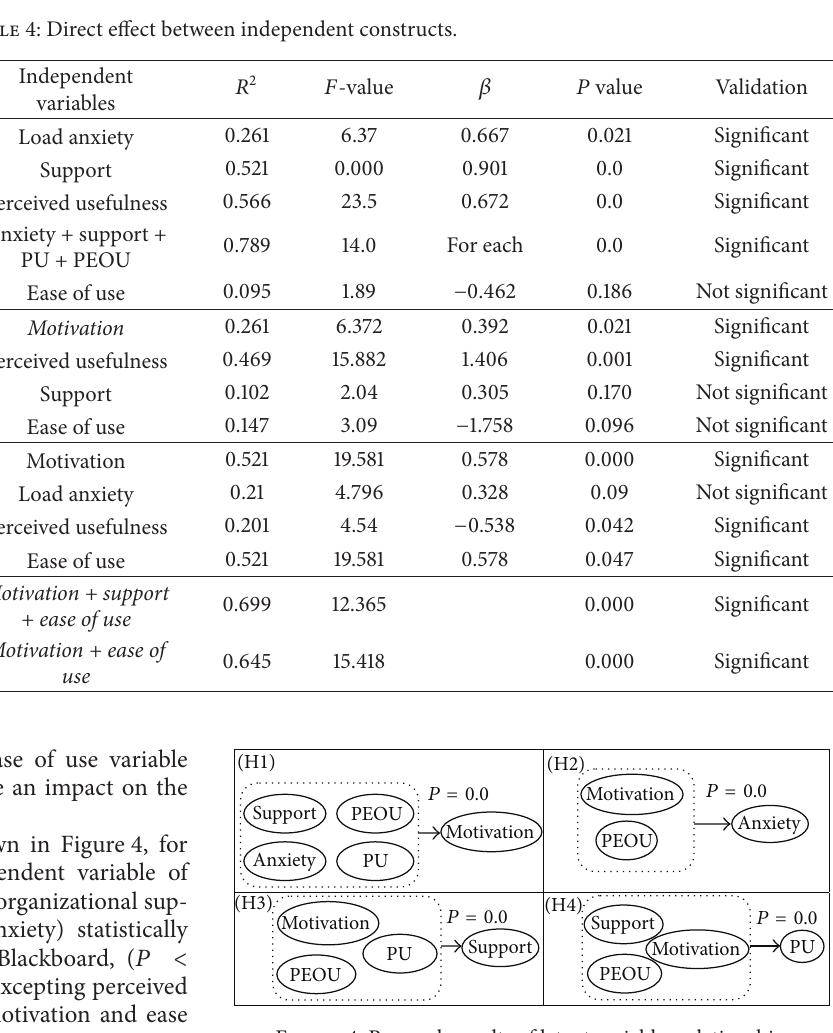
Figure 4: Research results of latent variables